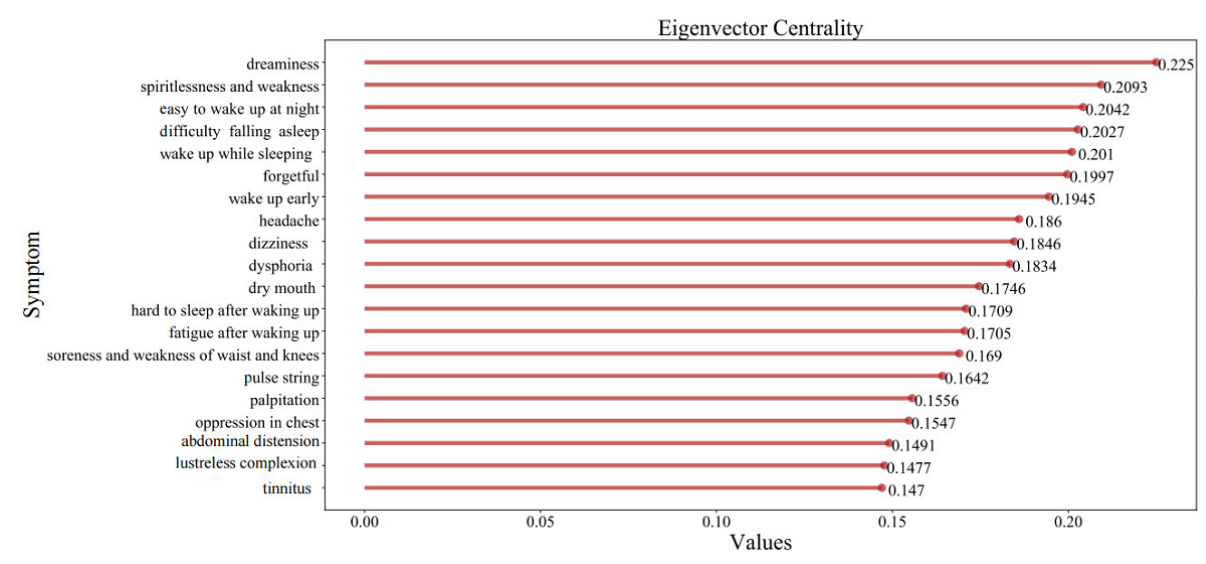
Figure 9. Eigenvector centrality of